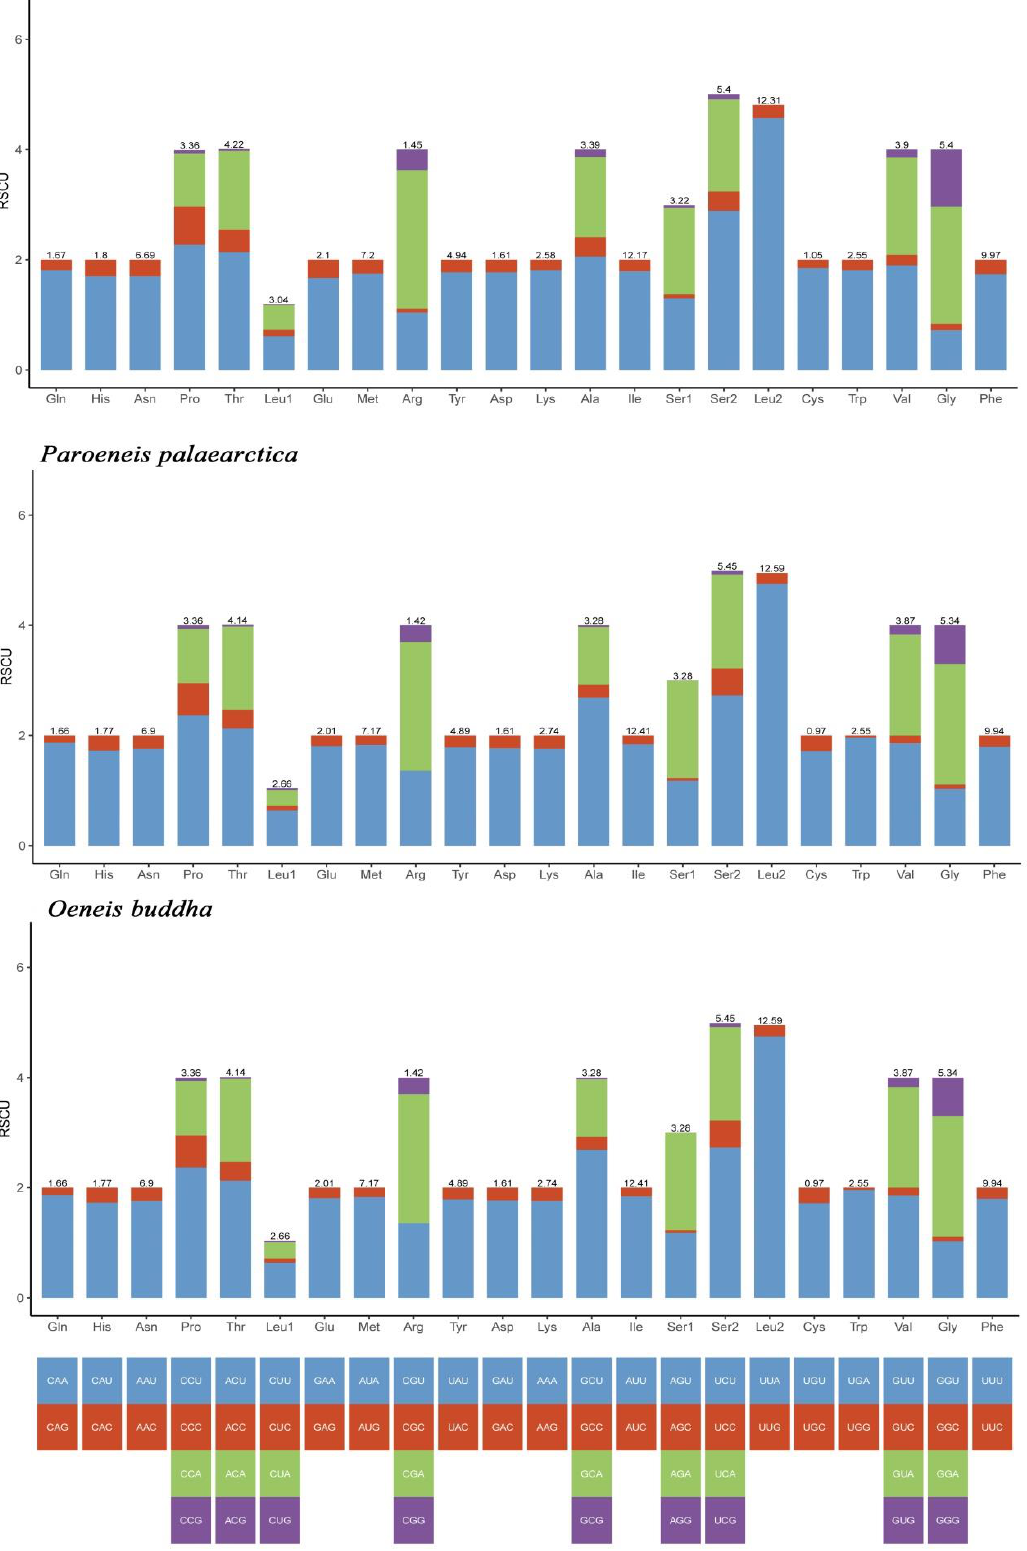
Figure 2. Relative synonymous codon usage (RSCU).